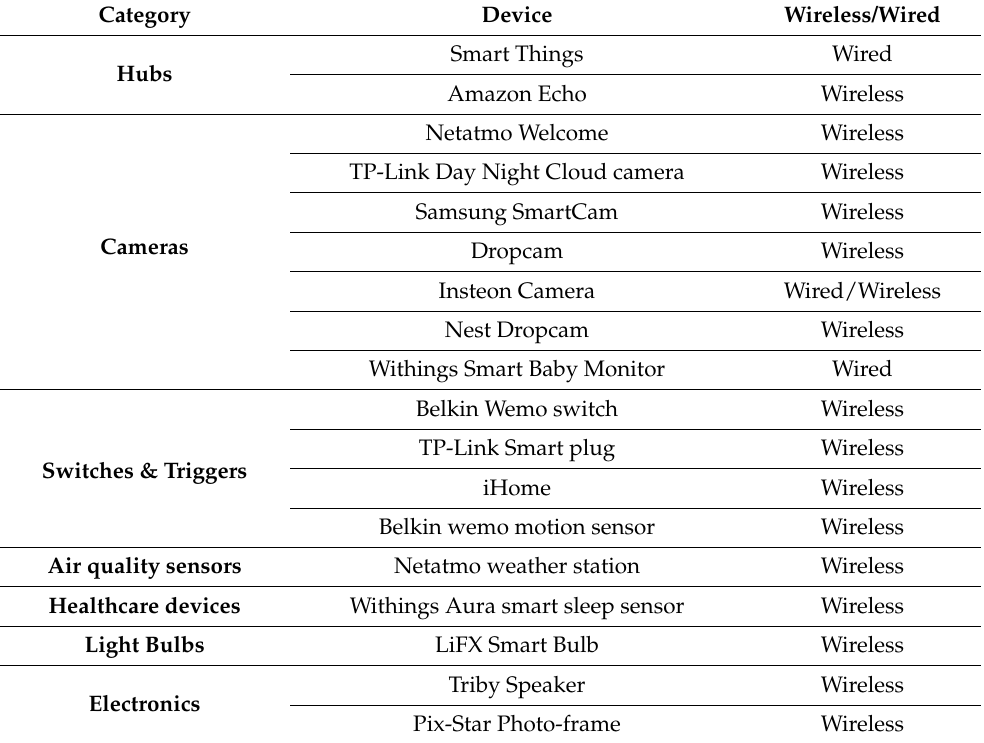
Table 4. List of IoT devices in the